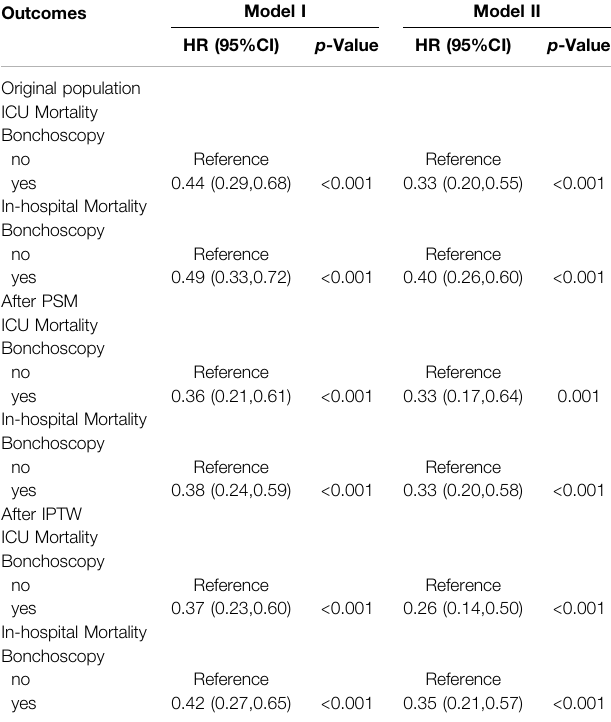
TABLE 2 | Results of Cox proportional hazard